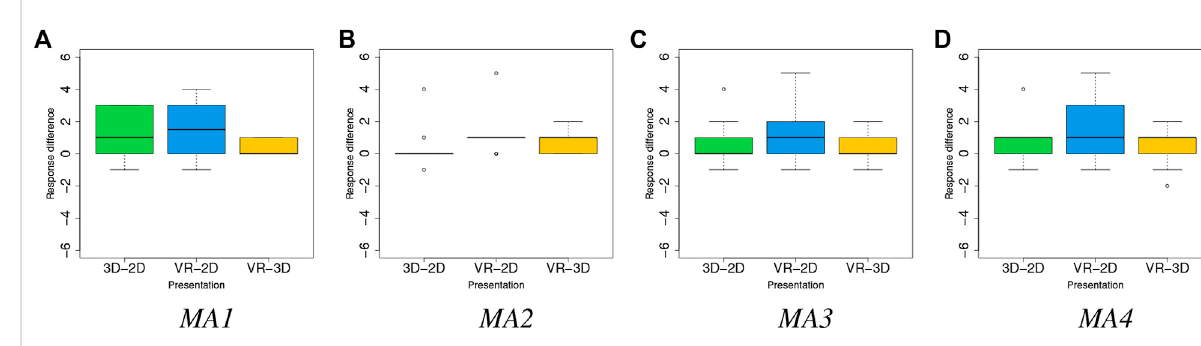
FIGURE 12 Distributions of difference in within-subjects ratings of MA1 (A) , MA2 (B) , MA3 (C) and MA4 (D)